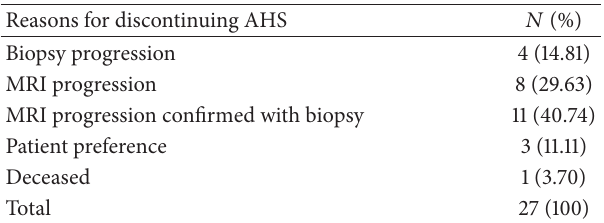
Table 5: Reason for intervention on AHS.